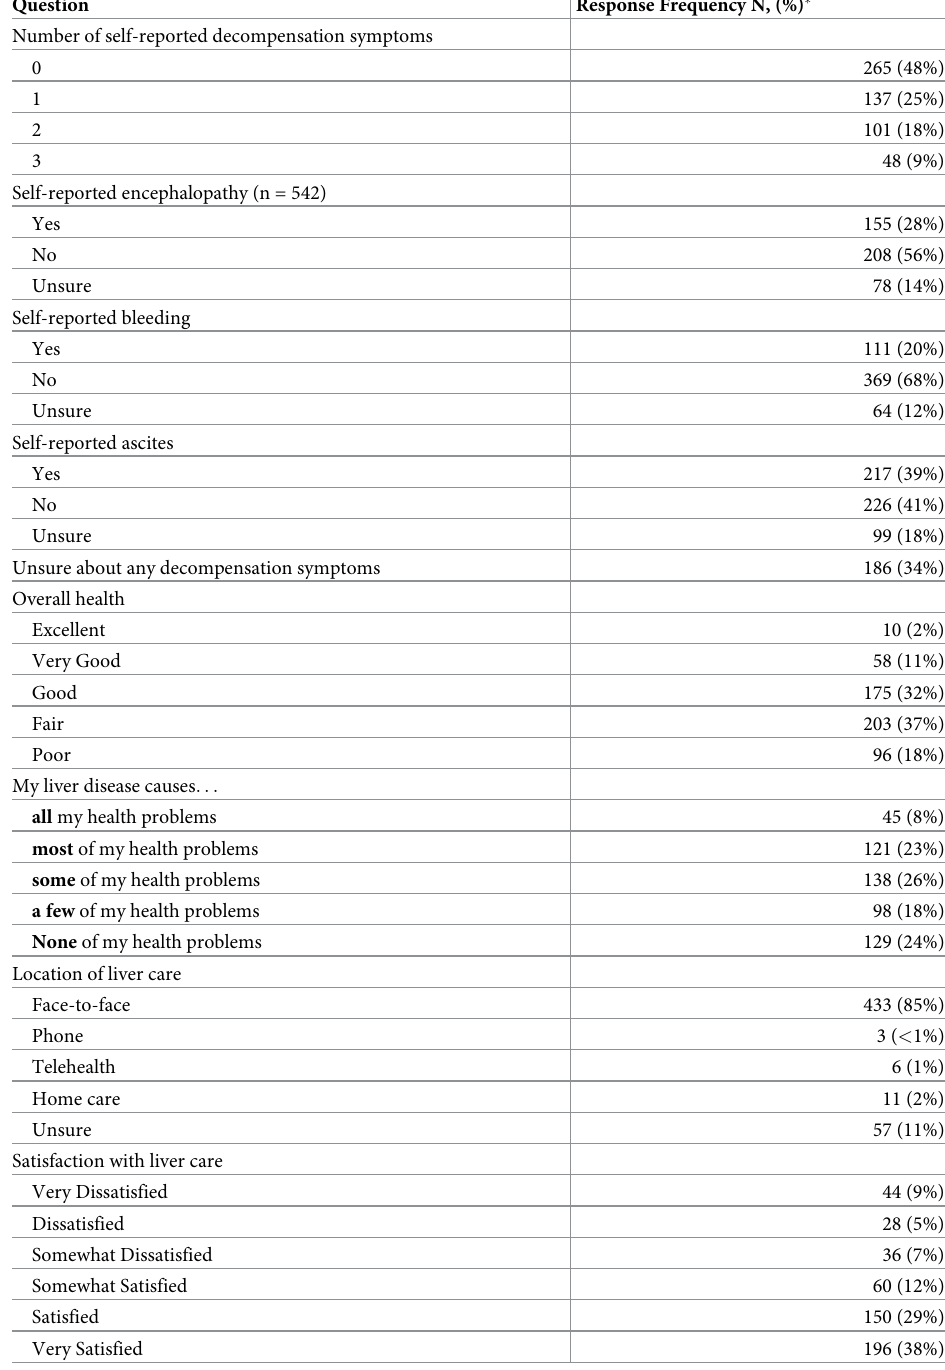
Table 2. Respondent liver disease and liver care characteristics. Question Response Frequency N, (%)